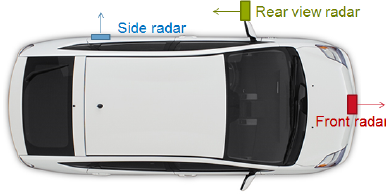
Figure 7. Three radars used for simultaneous vehicle tracking and shape